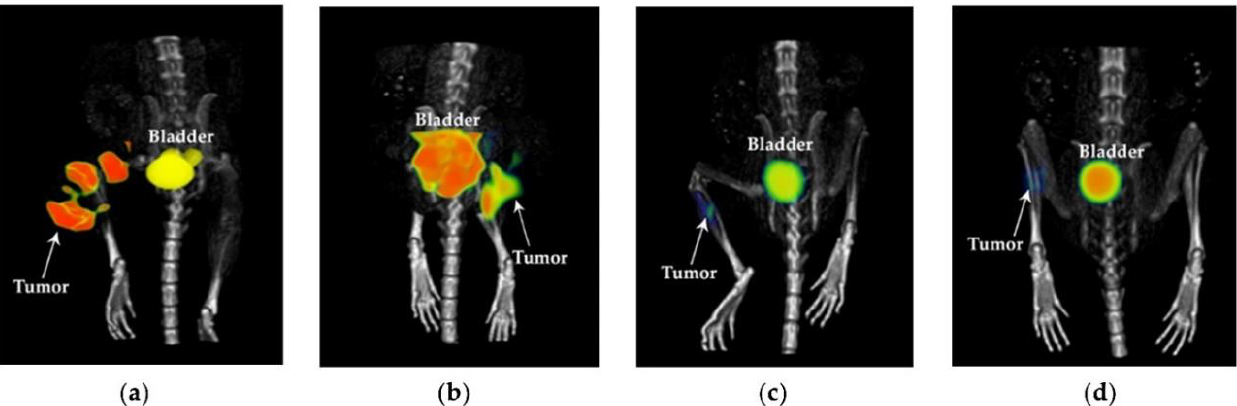
Figure 4. [ 18 F]FDG-microPET/CT imaging of the ( a ) control (untreated mouse), ( b ) 177 Lu 2 O 3 , ( c ) 177 Lu 2 O 3 -iPSMA, ( d ) 177 Lu 2 O 3 -iFAP groups at 21 days of treatment of mice bearing HCT116 tumors. The patient with multiple colorectal liver metastases (PSMA-positive; as determined by [ 99m Tc]Tc-iPSMA SPECT/CT imaging, received 177 Lu 2 O 3 -iPSMA under a “compassionate use” protocol. The activity, administered intravenously, for the evaluation of the